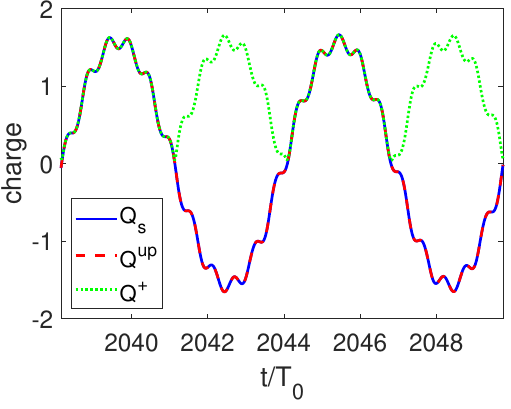
Figure 4. Evolutions of three different charge integrals Q s , Q up and Q + with time, the absolute values of which are mostly the same. T = 2 π/m is roughly the oscillation period of the field φ 0